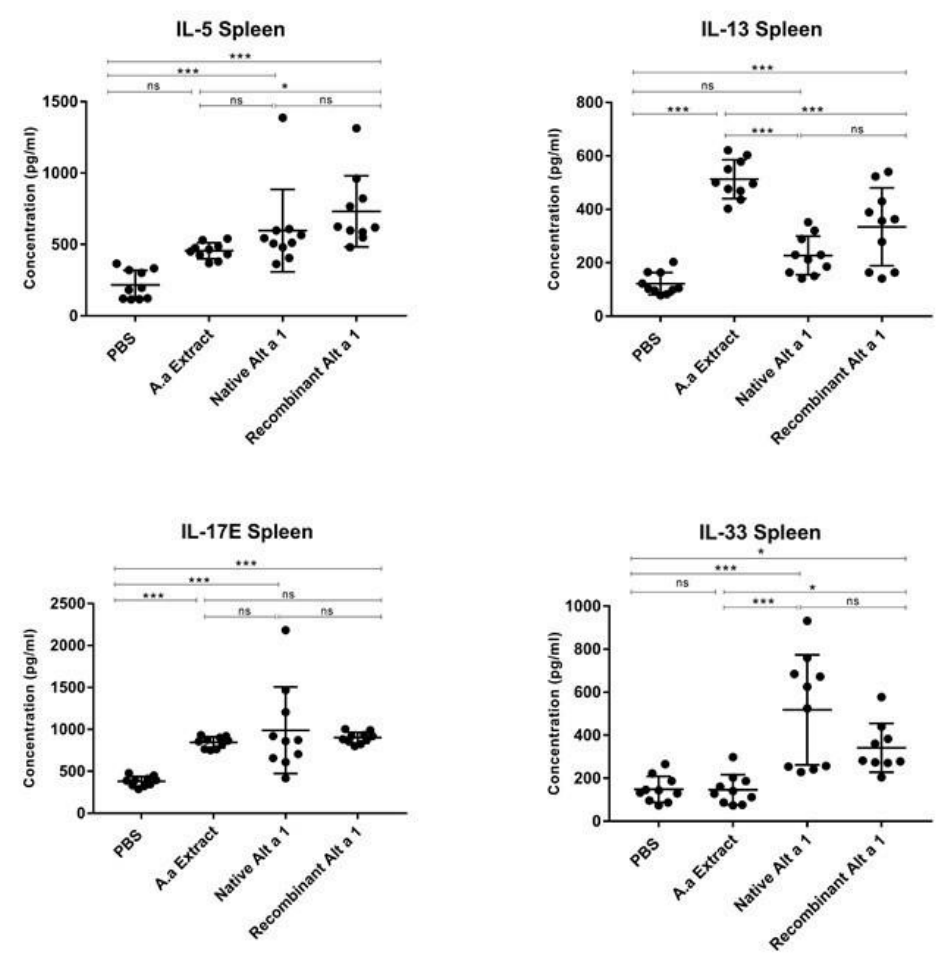
Figure 4. Quantification of the levels of cytokines, IL-5, IL-13, IL-17E and IL-33, analysed by ELISA in spleen homogenate in the respective groups of animals (PBS, A. alternata Extract, nAlt a 1 and rAlt a 1). Data shown as mean ± SEM. *, p < 0.05; ***, p < 0.001; ns: no statistically significant differences ( p > 0.05).